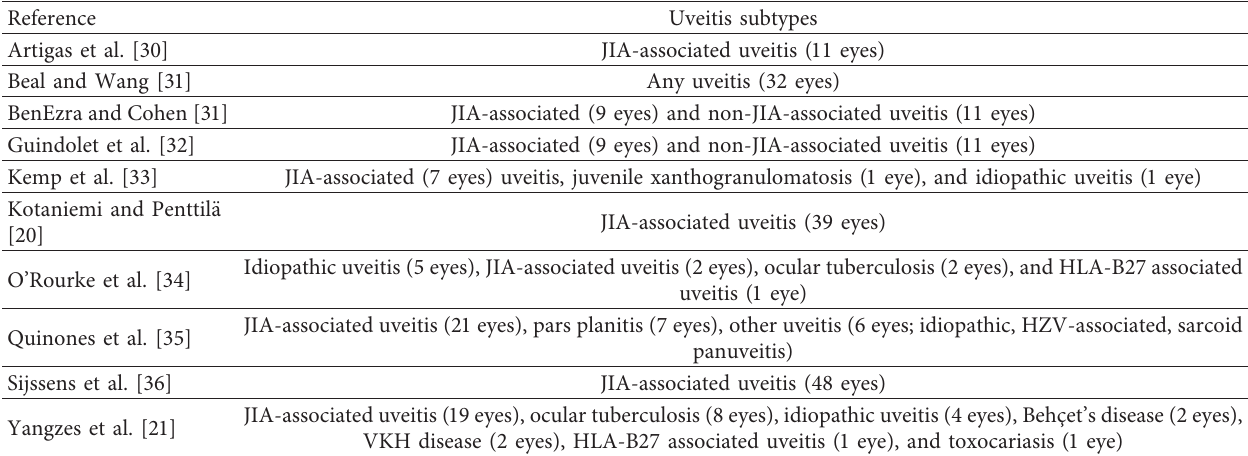
Table 2: Distribution of uveitis subtypes among eligible patients for this